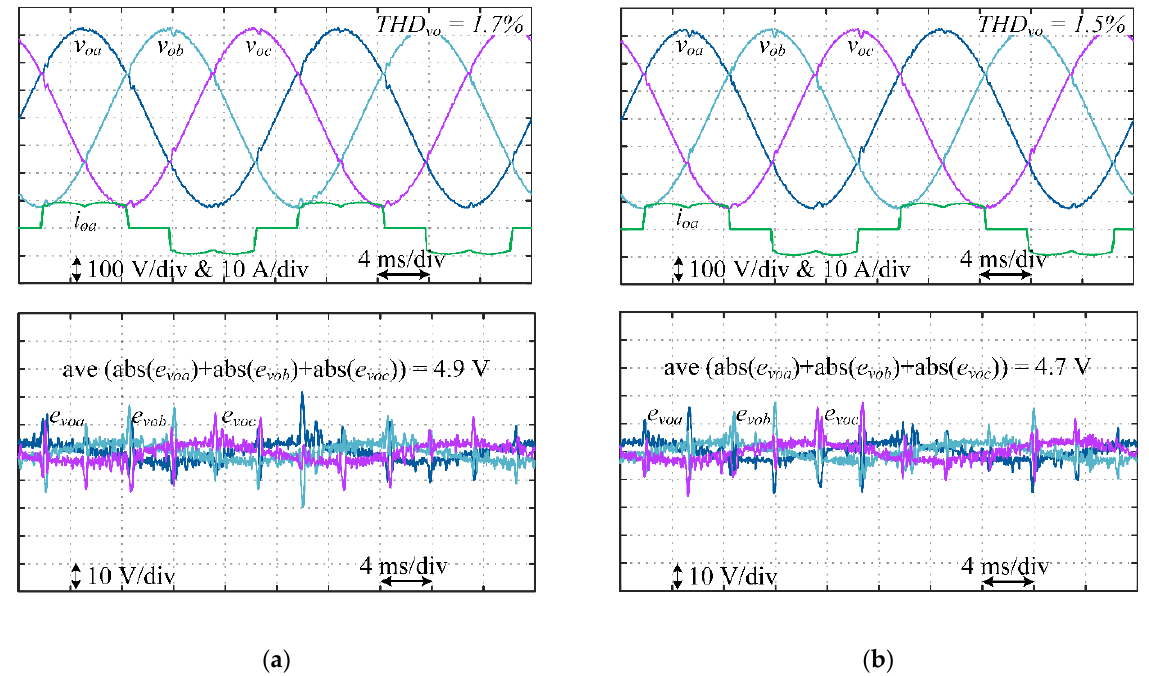
Figure 4. Simulation results showing steady-state performance under nominal nonlinear load (5 kW), ( a ) the proposed adaptive MPC, ( b ) conventional MPC.